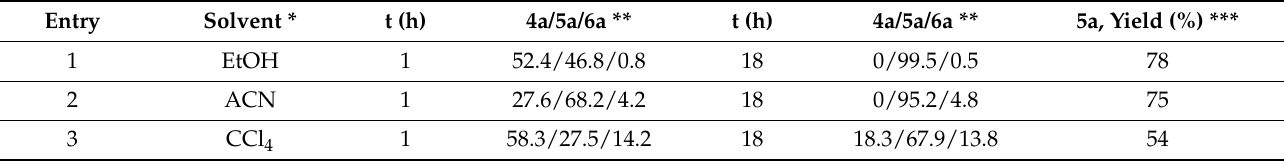
Figure 2. Synthesized compounds 5a – o . Table 1. Solvent effect on the formation of compounds 4a , 5a , and 6a